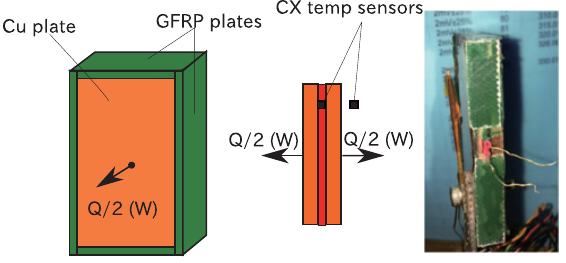
Figure 5. Experimental setup to measure the Kapitza conduc-